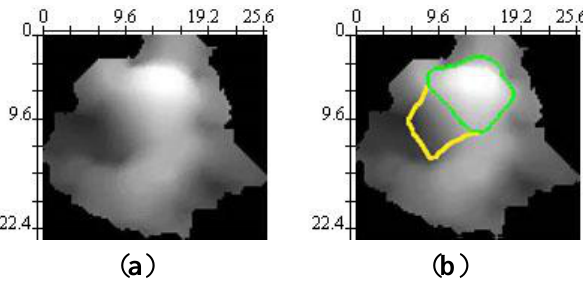
Figure 11. Example of a challenging case for contour delineation. ( a ) DSM segment. ( b ) Result of contour delineation (green) and expected left side boundary of the particle (yellow). Scalar unit in (a,b) is in